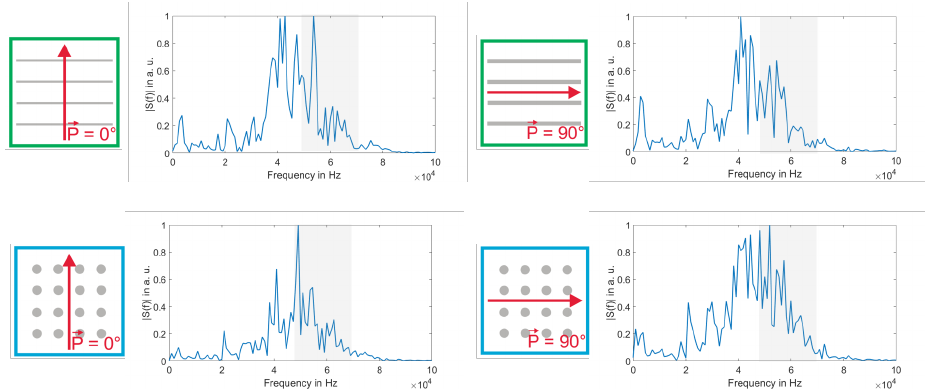
Figure 9. Probe polarization and fibre alignment (schematic), spectrum of the corresponding received signals for the samples Q40—Prism ( top ) and Q40||| Prism ( bottom